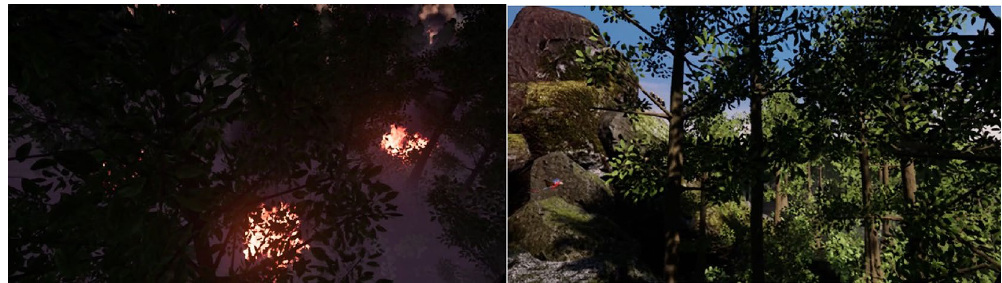
Figure 1. View from the perspective of the tree during the forest fire (to the left) and during daylight (to the Materials